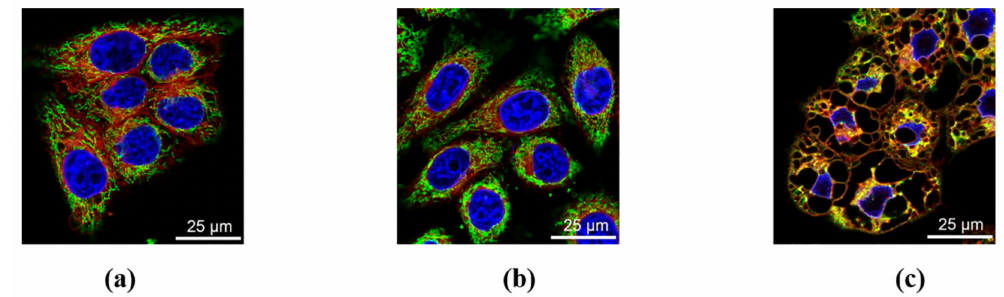
Figure 7. Confocal microscopy images of HEp-2 cells stained with Mitotracker Green (0.2 µ M), ER-tracker Red (1 µ M), and the H342 (1 µ g / mL). ( a ) Control; ( b ) cells after 5-h incubation with 1 mM DDC and ( c ) with 1mM DDC + 25 µ M B 12b . The membranes of vacuoles that appeared in cells were stained with red ER tracker but not with the green Mitotracker.